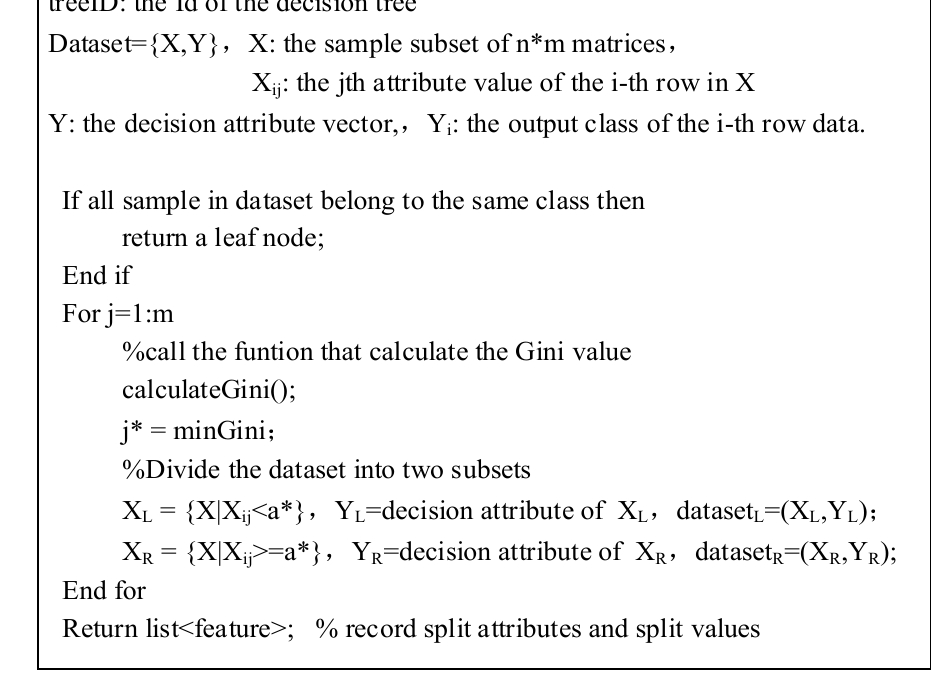
Figure 7. The pseudo code to construct a decision tree in Map task.